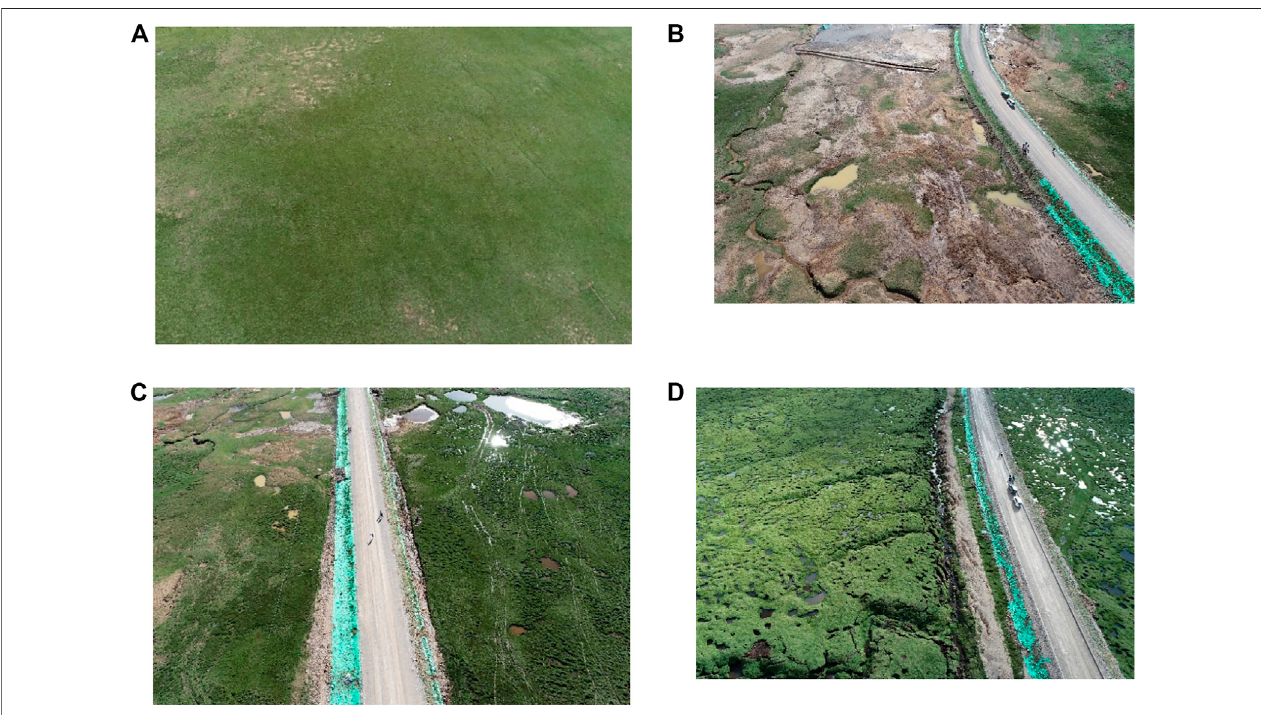
FIGURE 4 | Different waterlogged areas in permafrost wetlands along the road. (A) Almost no waterlogging. (B) Less waterlogging. (C) More waterlogging. (D) Severe waterlogging.